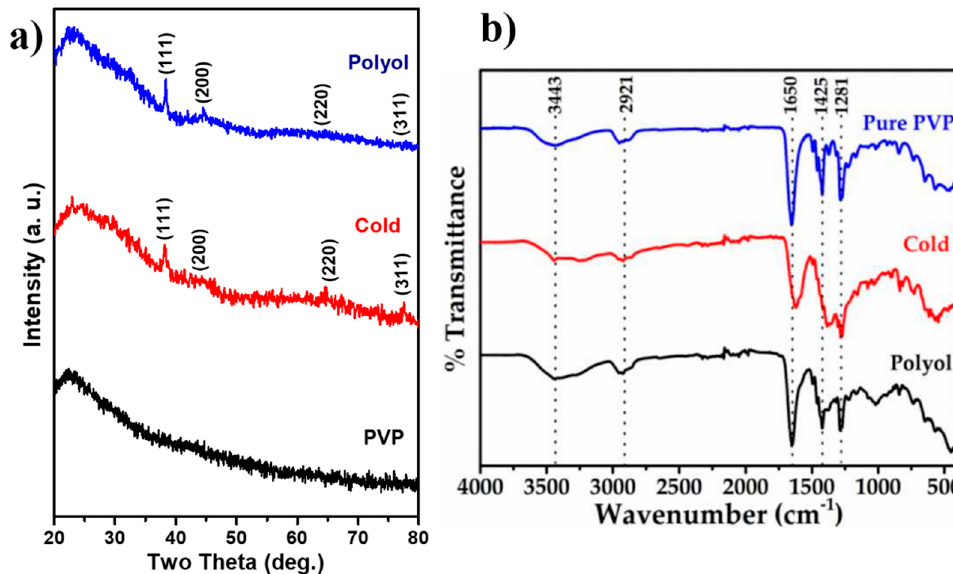
Figure 2. ( a ) XRD patterns for pure PVP, PVP capped Ag-NPs synthesized by using cold synthesis route, and PVP capped Ag-NPs synthesized by using polyol synthesis method, and ( b ) FTIR spectra for PVP, PVP capped Ag-NPs synthesized using polyol method, and PVP capped Ag-NPs synthesized using cold synthesis route.